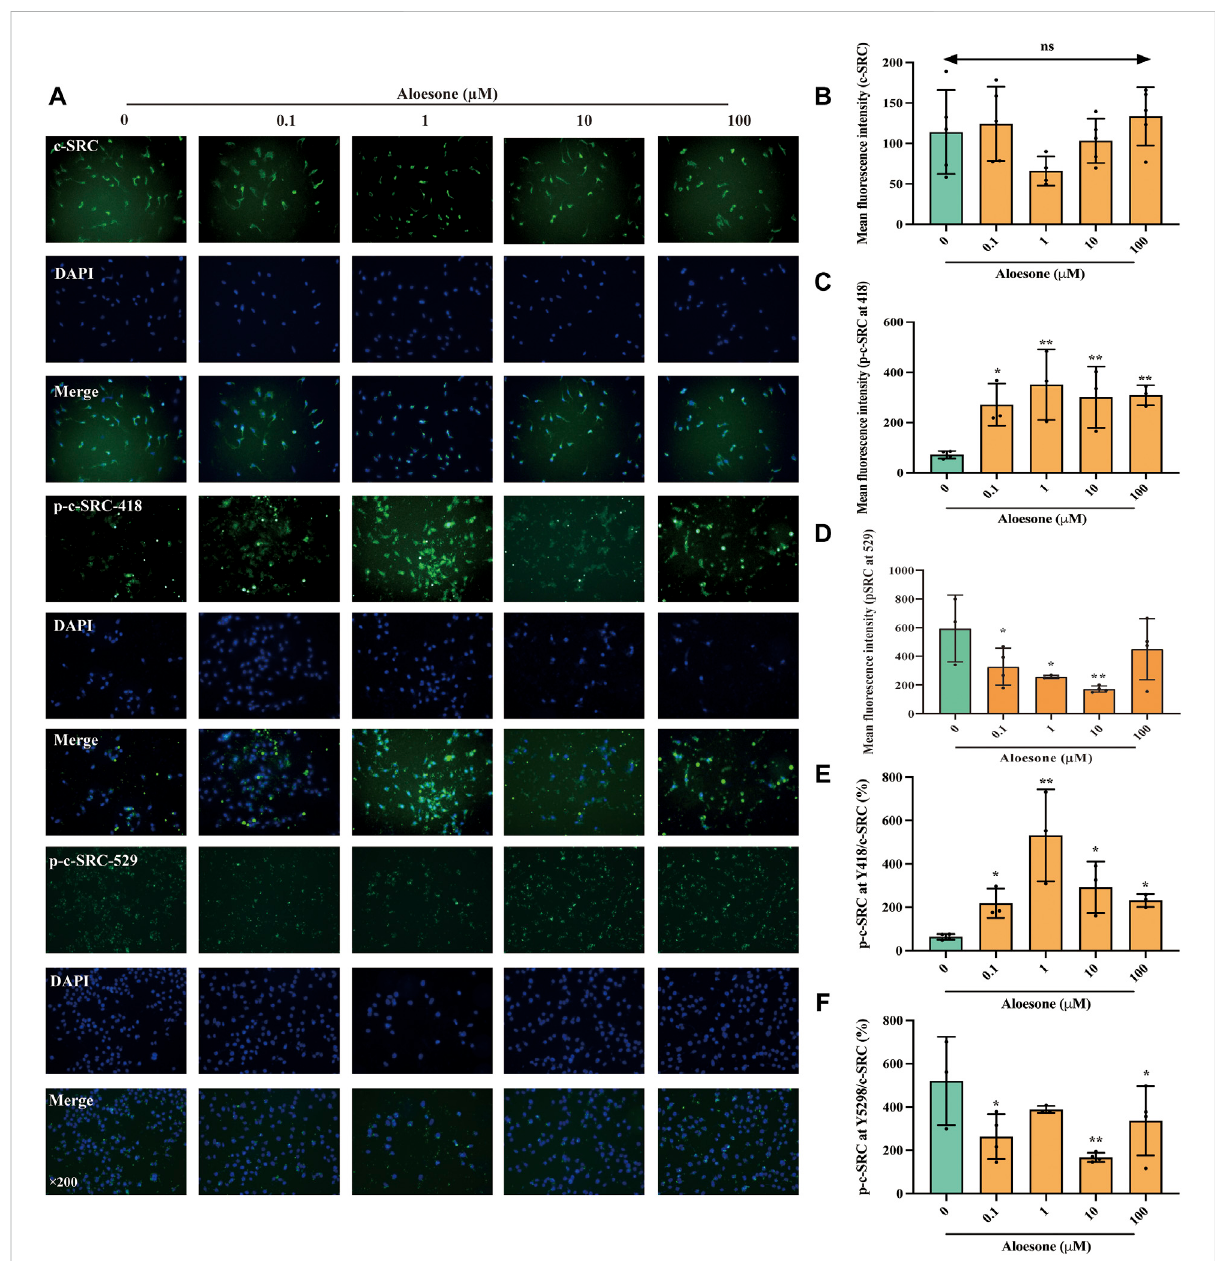
FIGURE 3 Immuno fl uorescence staining for c-SRC, p-c-SRC Y418, and p-c-SRC Y529 in HT22 cells treated with glutamate alone or combination of glutamate and aloesone. (A) Representative images. (B – F) Immuno fl uorescence density of c-SRC, p-c-SRC Y418, p-c-SRC Y529, ratio of p-c-SRC Y418 with c-SRC, and ratio of p-c-SRC Y529 with c-SRC. * p < 0.05 compared with the glutamate